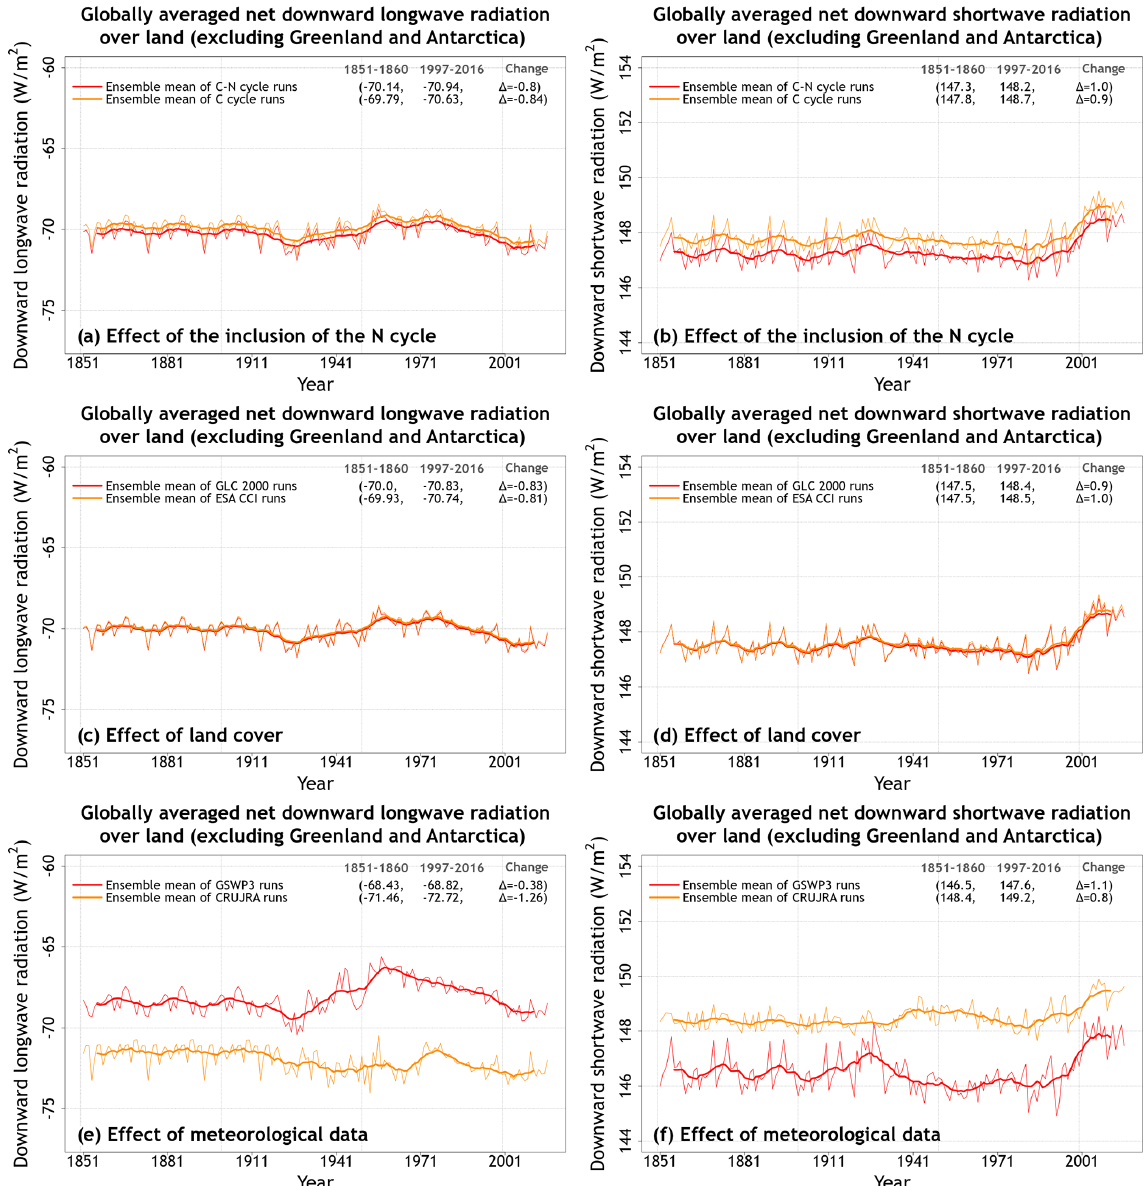
Figure A5. Time series of globally averaged annual net downward longwave and shortwave radiation (over all land area excluding Greenland and Antarctica), each averaged over the four ensemble members that are driven with and without N cycle (a, b) , that are driven with GLC- 2000- and ESA-CCI-based land cover (c, d) , and that are driven with GSWP3 and CRU-JRA meteorological data (e, f) . The thin lines show the individual years, and the thick lines show their 11-year moving average. Model values averaged over the pre-industrial (1851–1860) and present-day (1997–2016) time periods, and their difference, are also